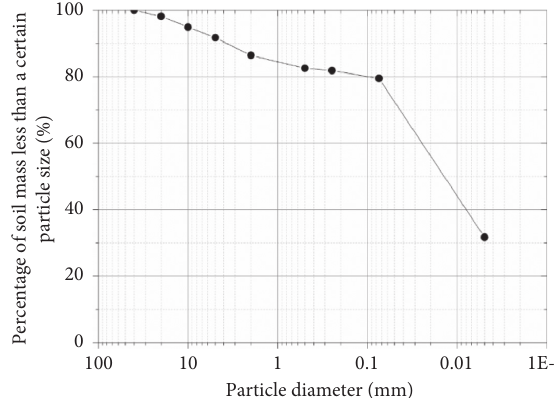
Figure 1: Grain size distribution curve of clay.